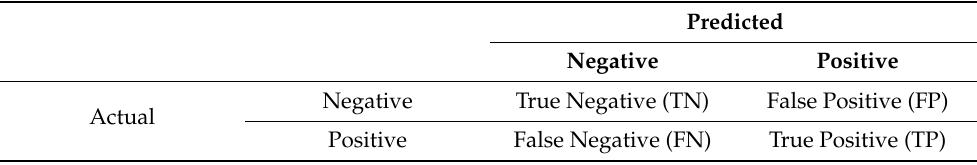
Table 1. Confusion